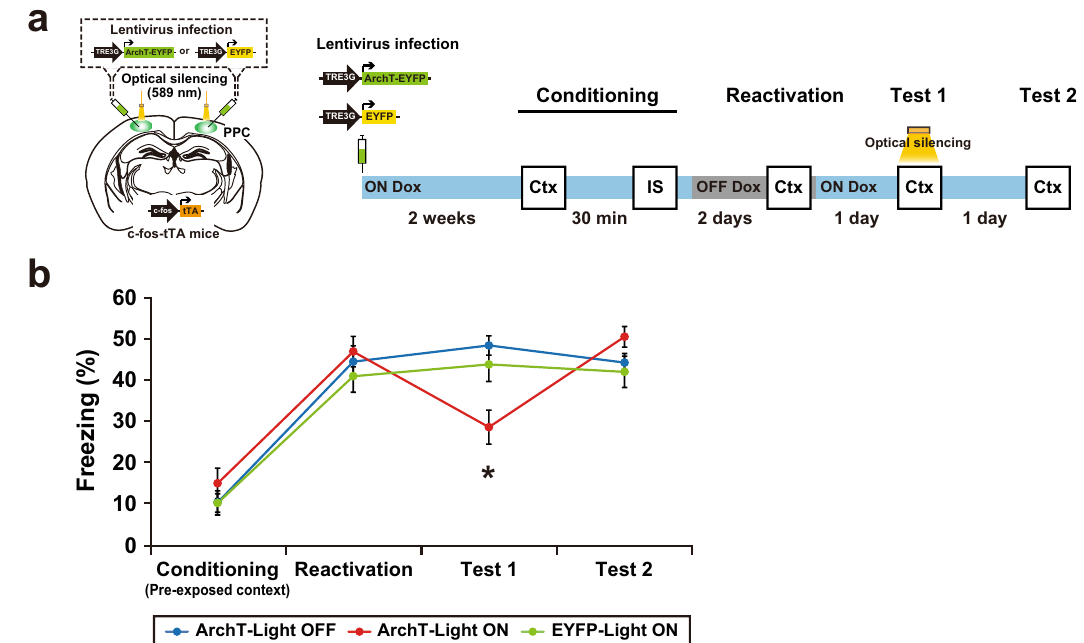
Fig. 4 The PPC regulates associative memory retrieval. a Schematics showing labeling of the PPC neurons in c-fos-tTA transgenic mice with the LVs TRE3G-ArchT-EYFP or TRE3G-EYFP (left). Schematic of the behavioral experiment with optical silencing (right). Blue and gray bars indicate the